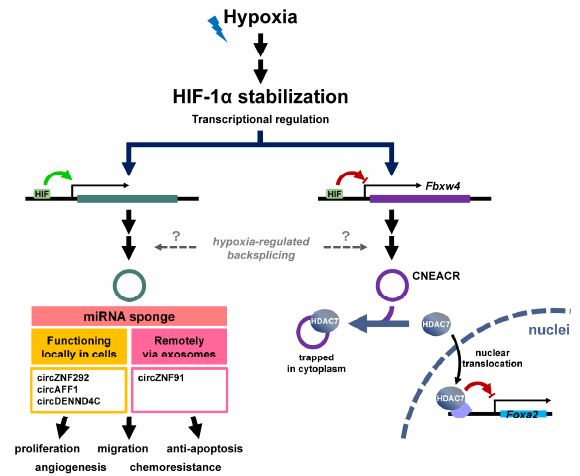
Figure 3. HIF-mediated transcriptional regulation of circRNAs. The majority of circRNA